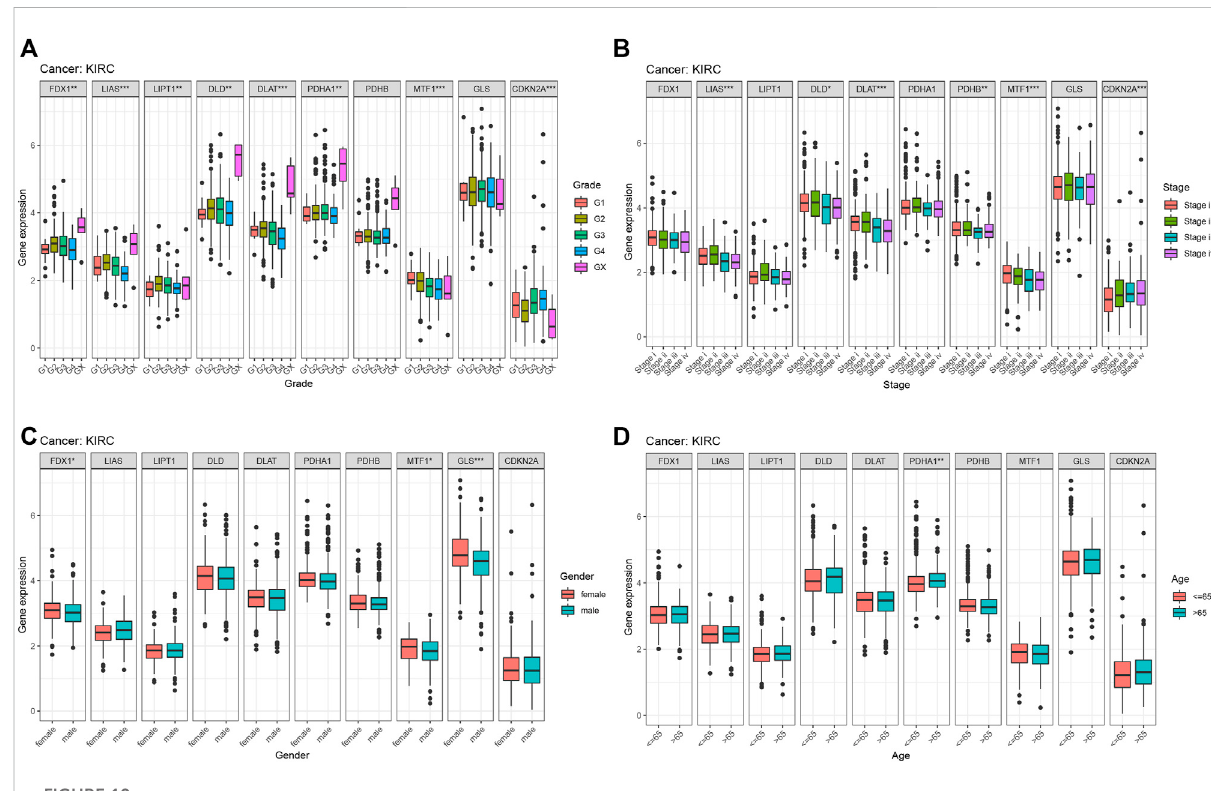
FIGURE 10 The relationship between cuproptosis-associated genes and clinical characteristics in KIRC. (A) Stage, (B) grade, (C) age, and (D)